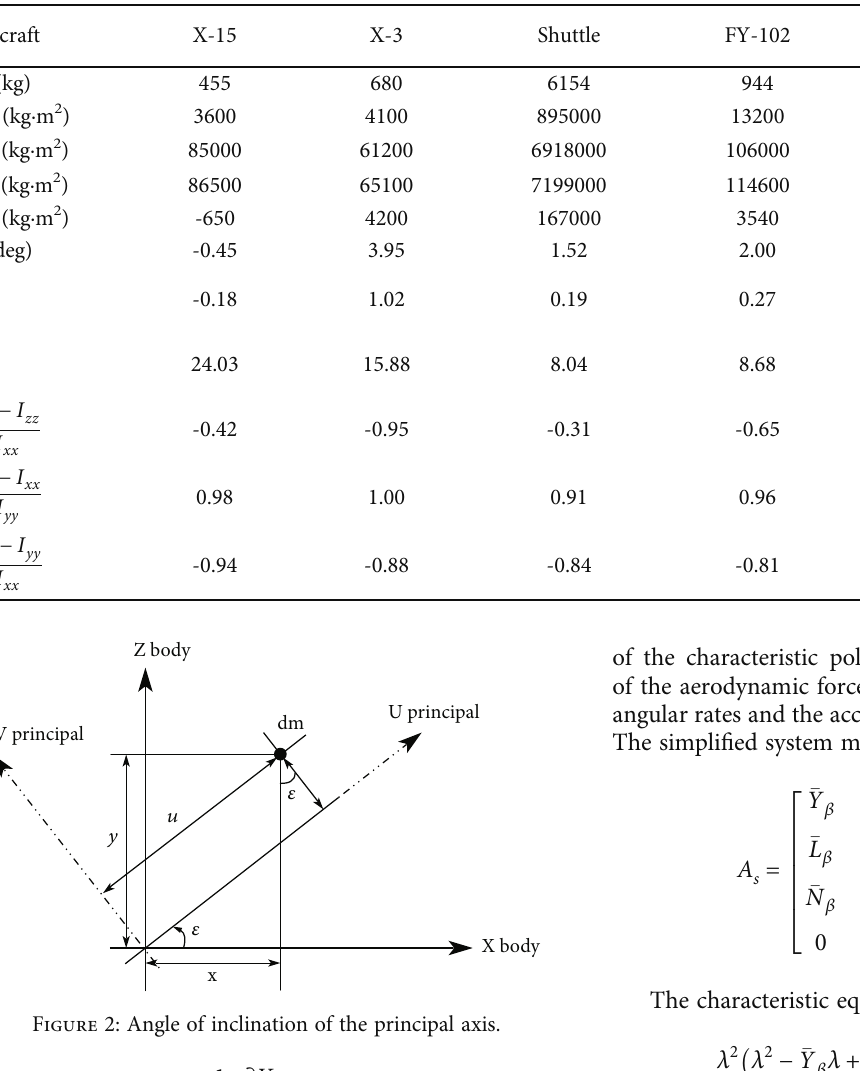
Table 2: Mass properties of coupling-prone aircraft [1].